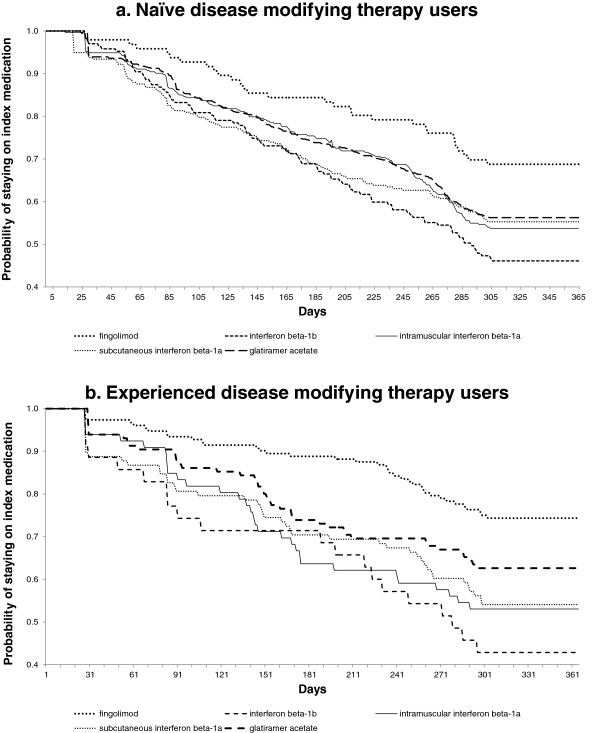
Time to discontinuation of initiated desease-modifying agent.